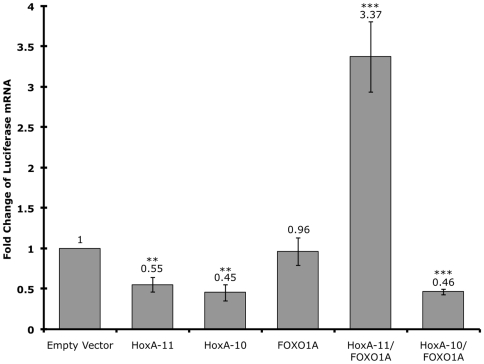
HoxA-11 and FOXO1A functionally cooperate to upregulate PRL expression.The expression of luciferase was assayed in HeLa cells transiently transfected with the dPRL-332/luc3 decidual PRL enhancer reporter construct, cotransfected with either empty expression vector, HoxA-11 alone, HoxA-10 alone, FOXO1A alone, or FOXO1A cotransfected with either HoxA-11 or HoxA-10. Results are shown as fold changes relative to luciferase expression in cells cotransfected with dPRL-332/luc3 and empty expression vector. n = 8 replicate experiments, means±SEM. **, P<0.05; ***, P<0.001 (t-test compared to empty vector).